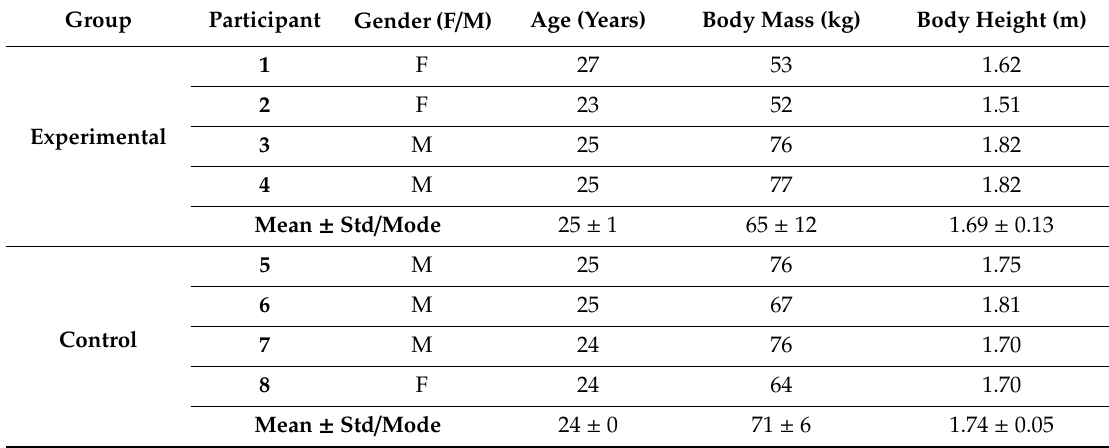
Table 1. Gender (female / male), age (years), body mass (kg), and body height (m) for each participant. Mean and standard deviation (std) of age, body mass, and body height for the experimental and control